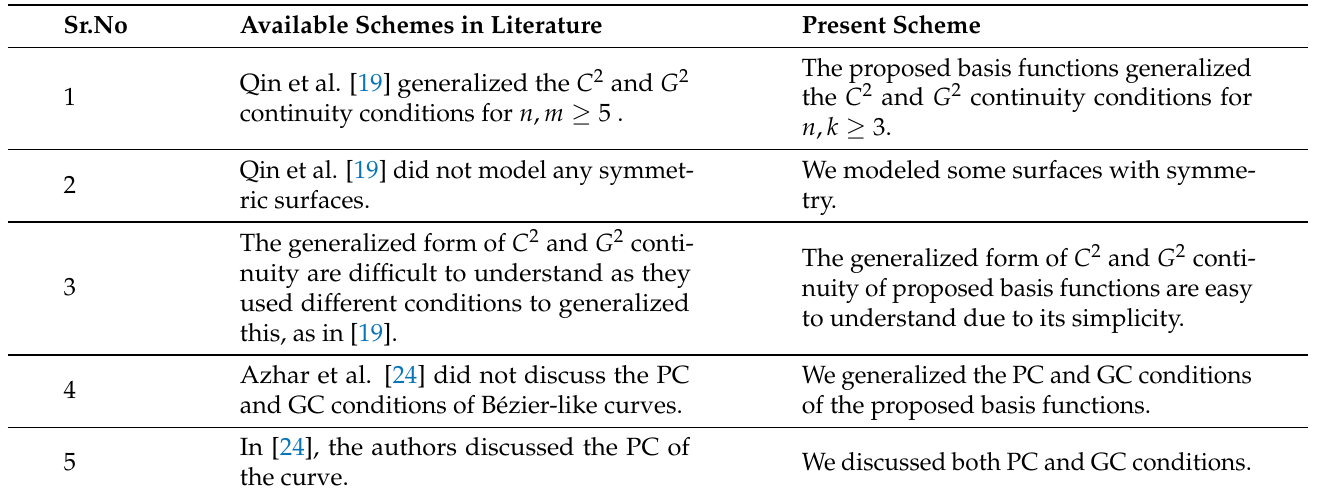
Table 1. Contrasting research